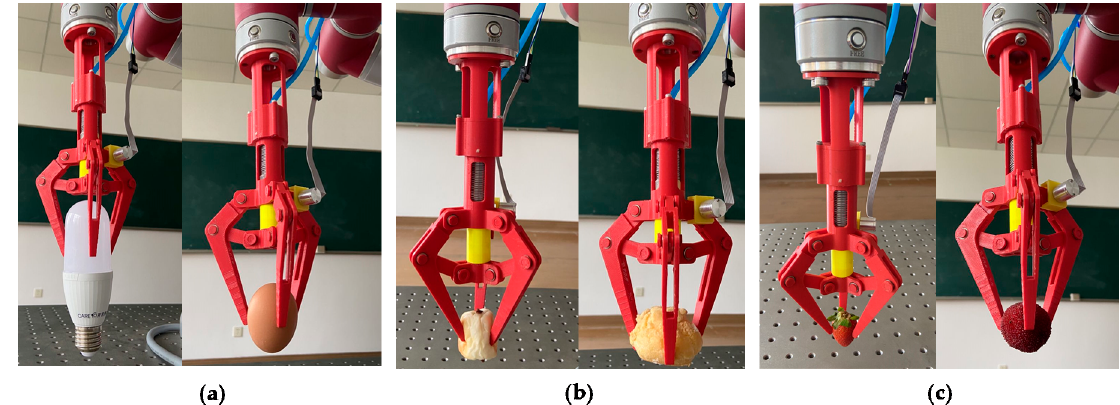
Figure 13. Static gripping test of the gripper for controlling gripping force and fingertip displacement. ( a ) Control the gripping force to 2 N to grip light bulb and raw egg, ( b ) control the fingertip displacement to 3 mm to grip bread and cake, and ( c ) control the gripping force to 1 N or the fingertip displacement to 1 mm to grip strawberry and bayberry.